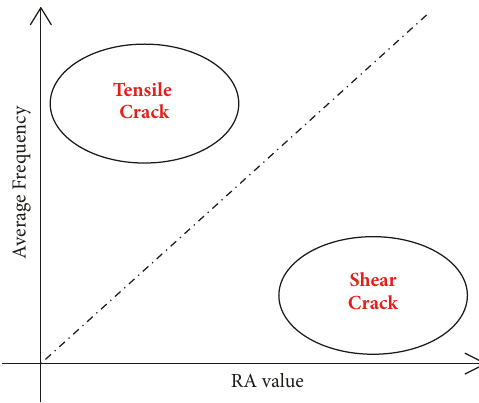
Figure 9: Conventional crack classification